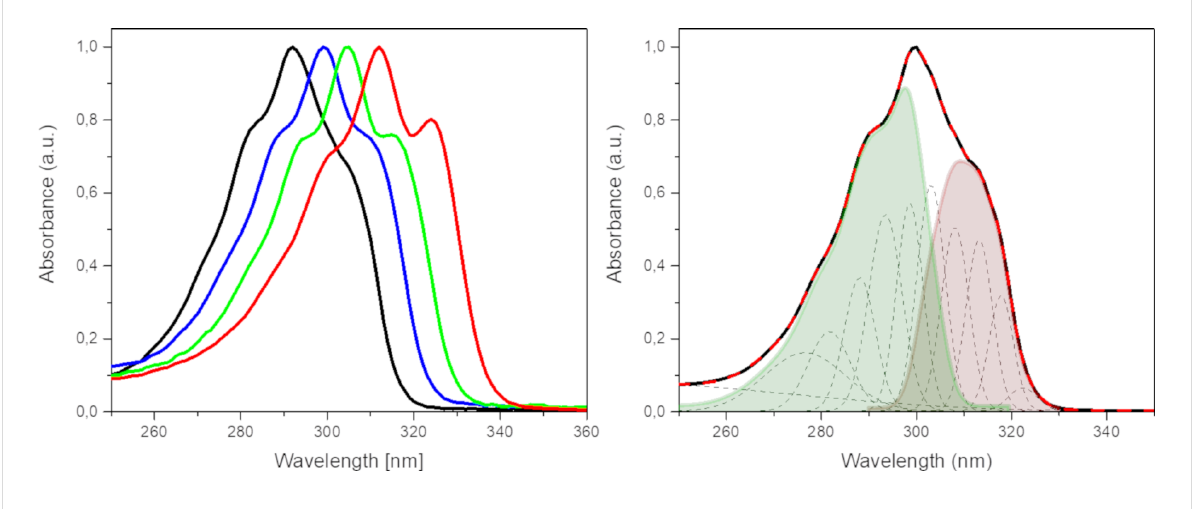
Figure 6: Normalized absorption spectra of heteroacenes DTT 1 (black line), DTS 2 (blue line), DST 3 (green line), and DSS 4 (red line) in dichloro- methane (left). Gaussian deconvolution analysis of the absorption spectrum of DTT 1 (right): Gaussian deconvolution peaks (doted black lines), S 1 transition (light red curve, balanced sum of the first 5 Gaussians), S 2 transition (light green curve, balanced sum of Gaussians 6 to 10), and complete cumulative peak-fit (doted red line).